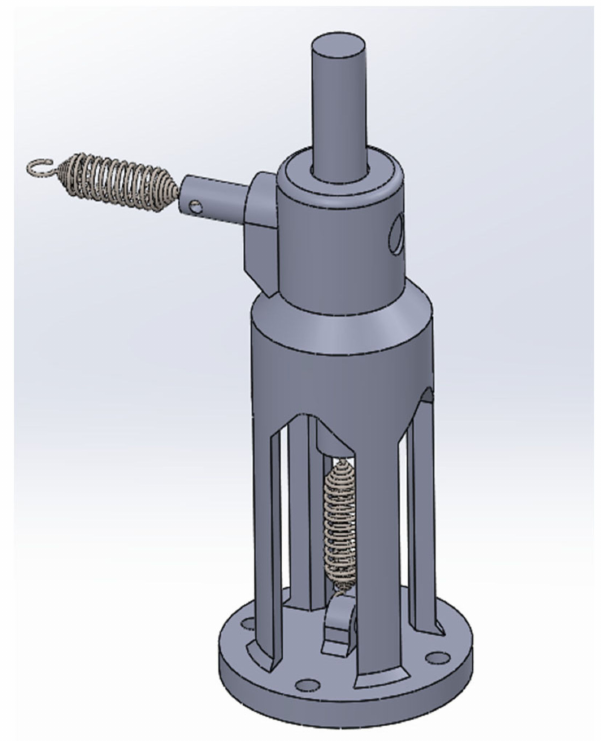
Figure 3. SMA actuator layout.